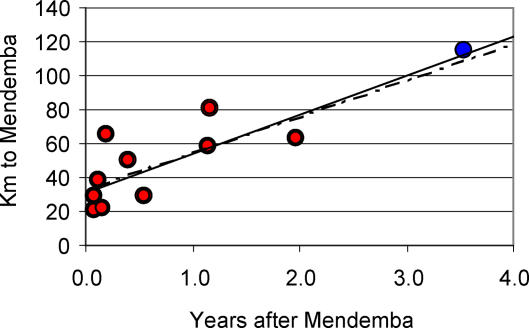
Spatial Spread from 2001–2005Distance of each human outbreak site from the initial outbreak at Mendemba village, Gabon, plotted as a function of time after the Mendemba outbreak. Dashed regression line uses only outbreaks from 2001–2003 (R2 = 0.43, p = 0.04). Solid regression line includes May 2005 outbreak at Etoumbi village (R2 = 0.73, p < 0.001).